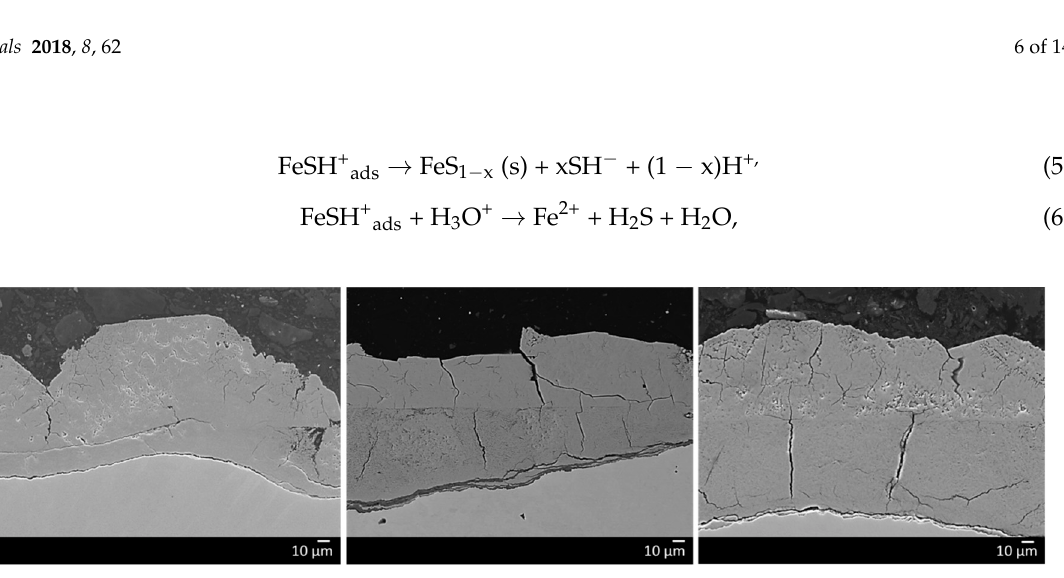
Figure 3. Scanning electron microscopy (SEM) images of the cross-sections of the low Mo (A) material ( left ), low Mo (B) material ( middle ), and high Mo material ( right ).